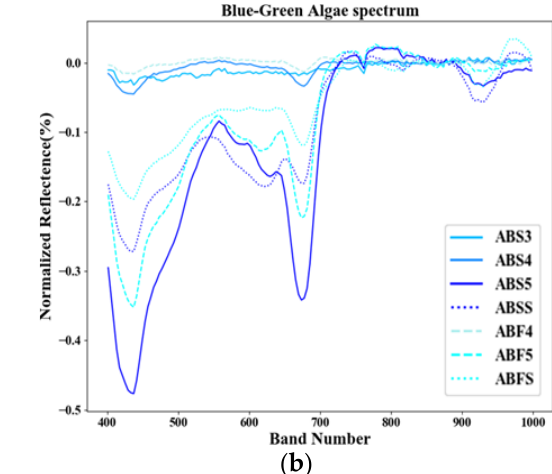
Table 4. Absorption wavelength range of selected blue-green algae.